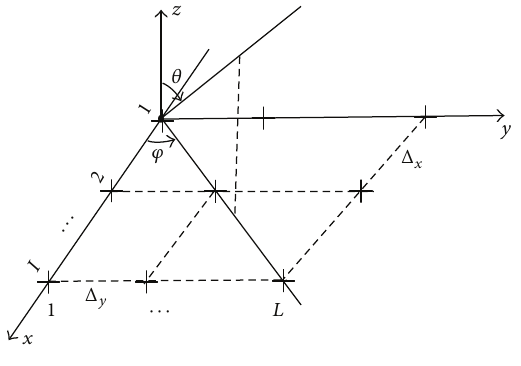
Figure 1: Planar antenna